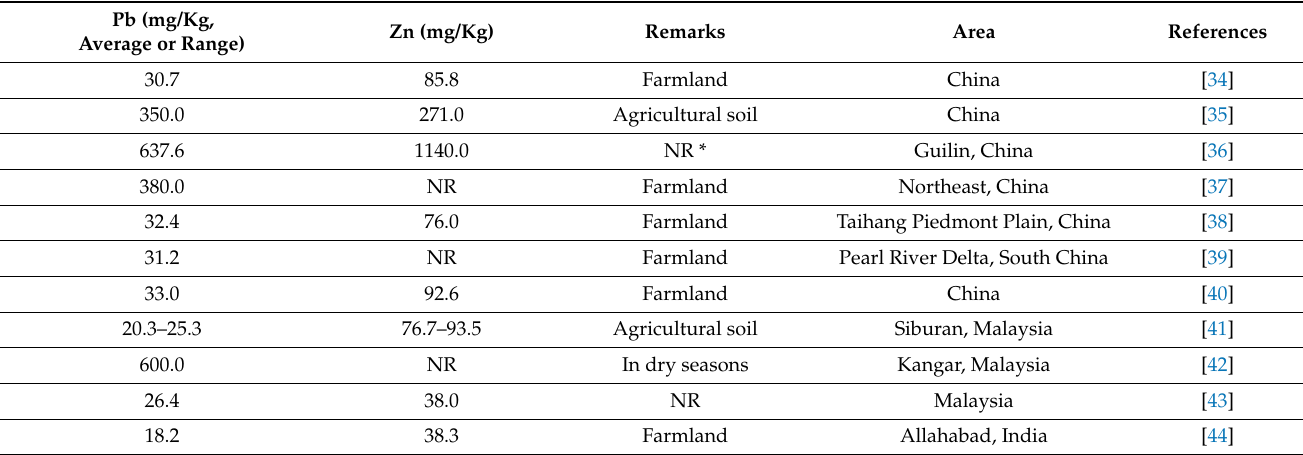
Table 1. Pb and Zn concentrations in soil